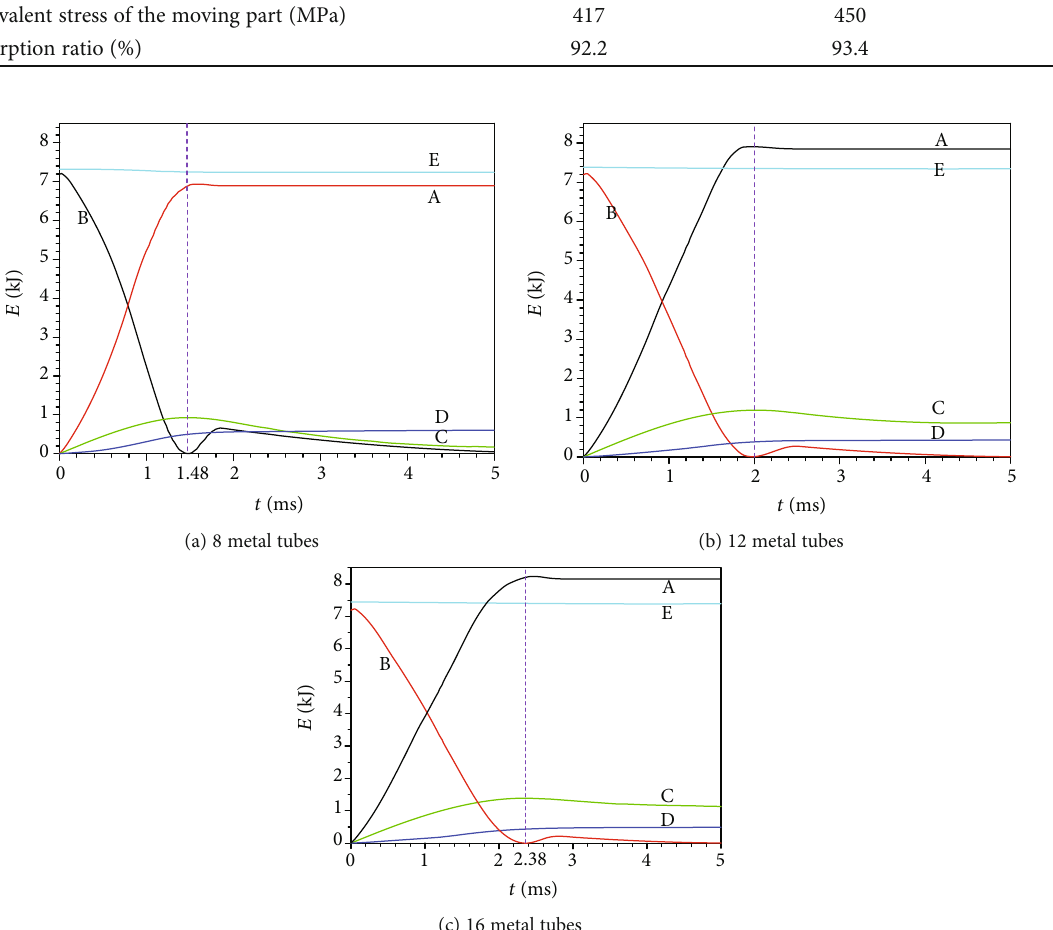
Figure 12: Energy conversion curves in the process of compression and energy absorption of di ff erent numbers of stacked tubes.